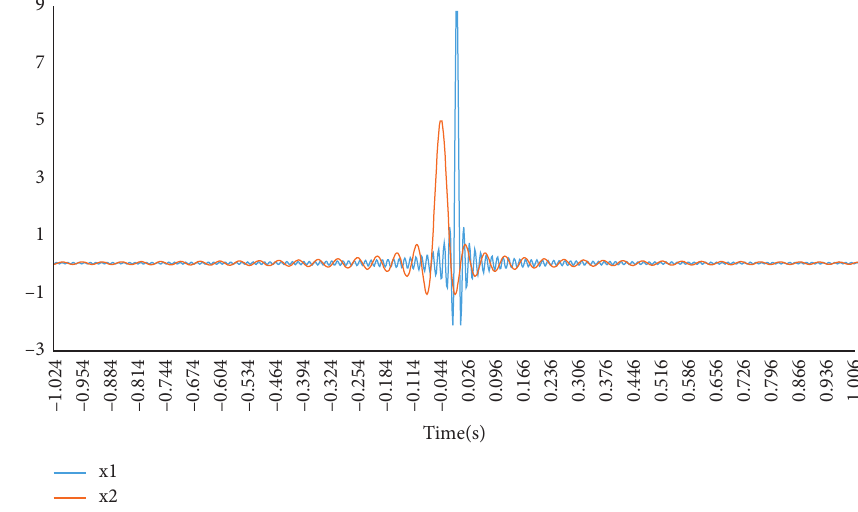
Figure 4: Original signals for x 1 and x